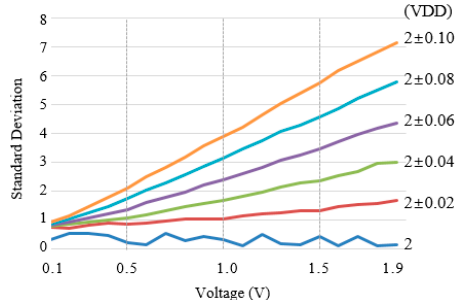
Figure 6. The standard deviation of the sampled ADC data according to VDDs and input voltage signals of the ADC in the range of 0.1 V to 1.9 V.